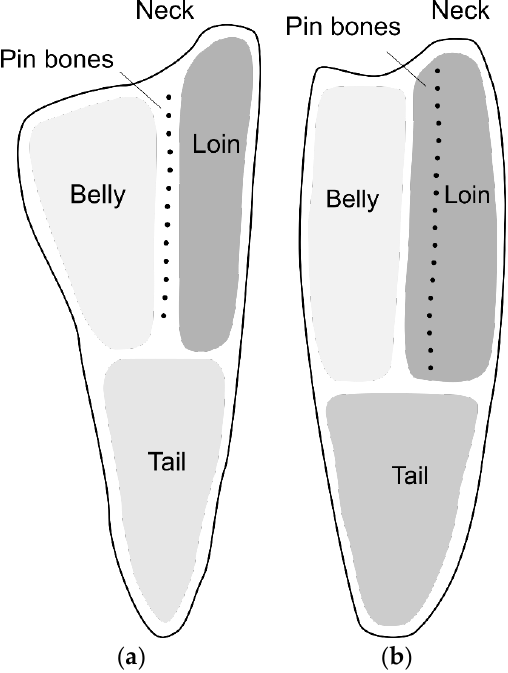
Figure 1. Schematic drawing of fish fillets showing the position of the pin bones. ( a ) Cod fillet. ( b ) Salmon fillet.